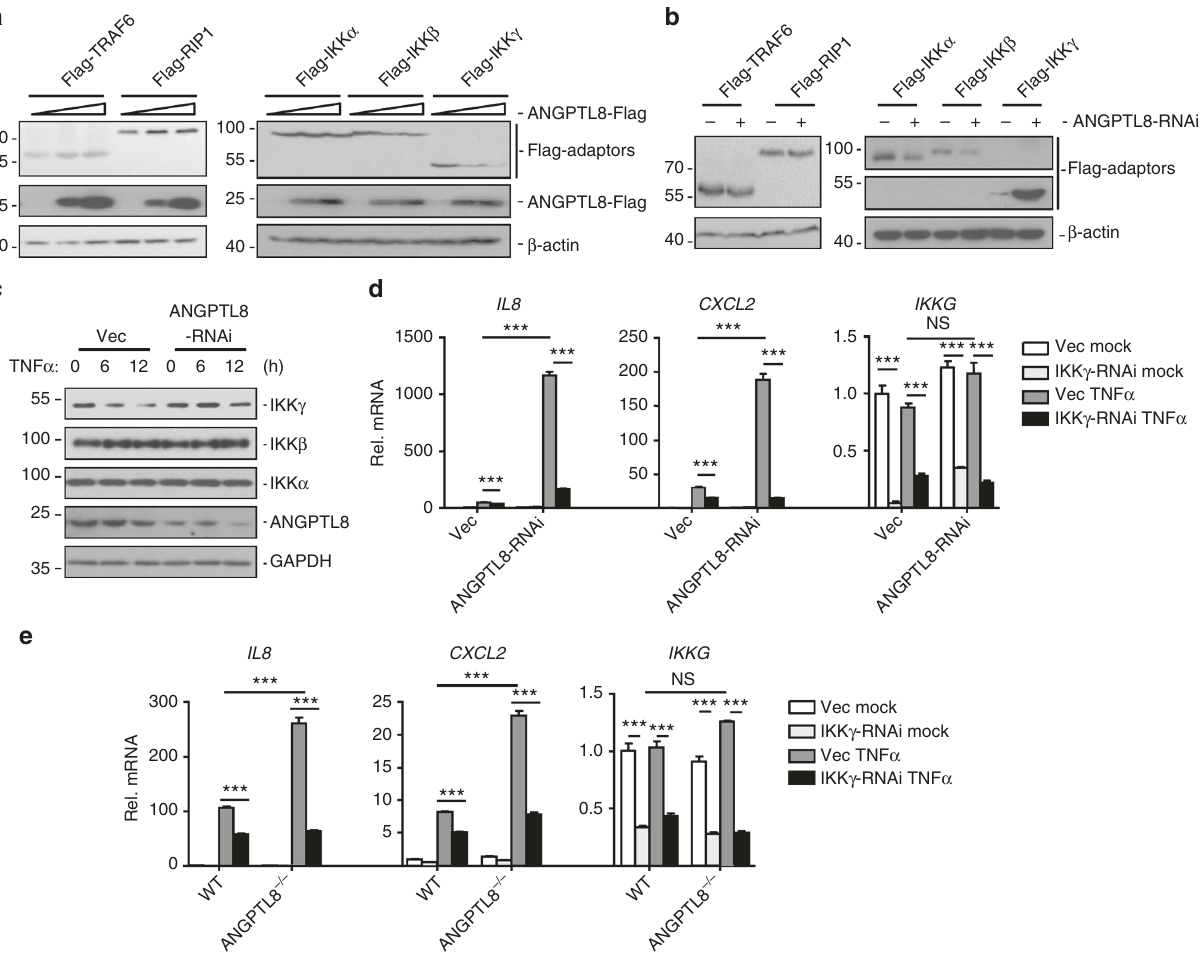
Fig. 5 ANGPTL8 facilitates the degradation of IKK γ . a Effects of ANGPTL8 overexpression on the expression level of transfected TRAF6, RIP1, IKK α , IKK β or IKK γ in HEK293T cells. b Effects of ANGPTL8-RNAi on the expression level of transfected TRAF6, RIP1, IKK α , IKK β , or IKK γ . c Effects of ANGPTL8-RNAi on the expression levels of the endogenous IKK α , IKK β or IKK γ after TNF α and CHX co-treatment. The indicated cells were treated by CHX (200 μ g/mL) for 1 h, followed by TNF α treatment for the indicated time. d Knockdown of IKK γ inhibits ANGPTL8-RNAi facilitated NF- κ B activation triggered by TNF α (2 h) in the ANGPTL8-RNAi or control cell lines ( n = 3). e Knockdown of IKK γ inhibits ANGPTL8 de fi ciency-facilitated NF- κ B activation triggered by TNF α for 2 h ( n = 3). Data are shown as the mean ± SEM, unpaired two-tailed student ’ s test was used for statistics ( d , e ). *** p < 0.001, NS > 0.05. Data are representative of three independent